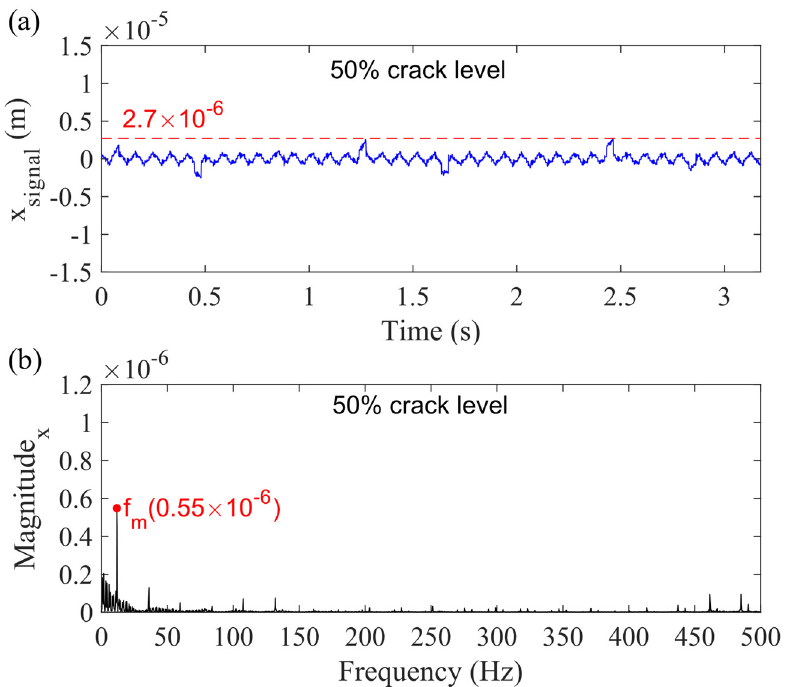
Figure 20. Sum vibration response with 50% sun gear crack level for Case 6 in ( a ) time domain and ( b ) frequency domain in x g -direction. Table 5. The maximum value in the time domain for each case with different crack levels.